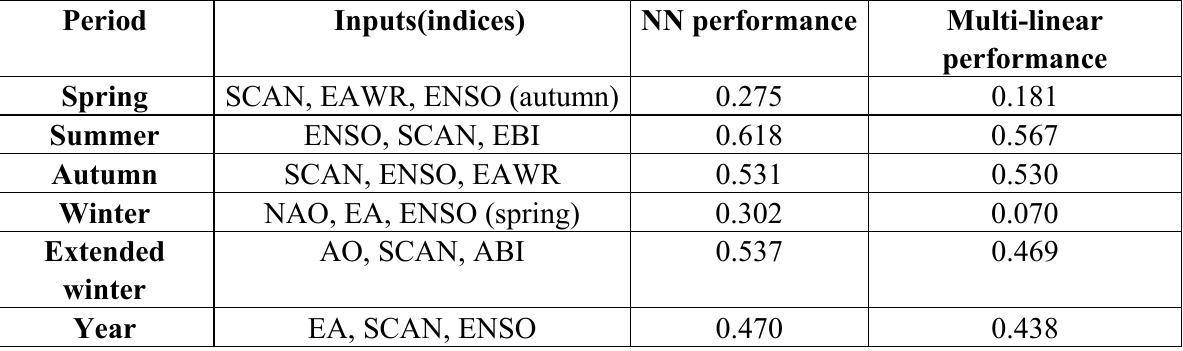
Table 3. NN performance of the best models and comparison with multi-linear